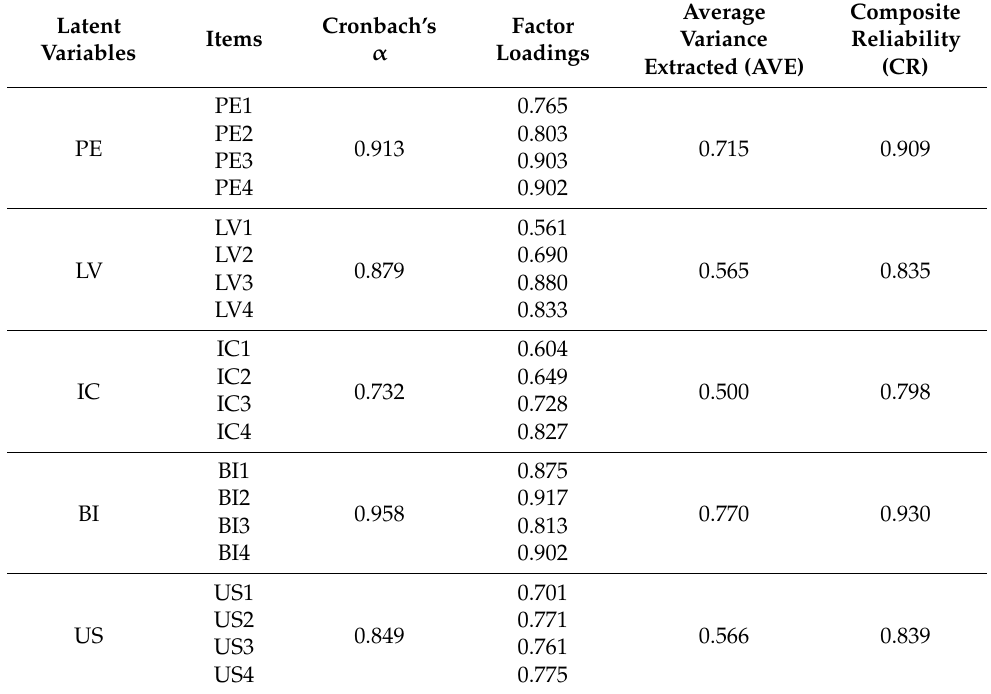
Table 4. Construct validity and